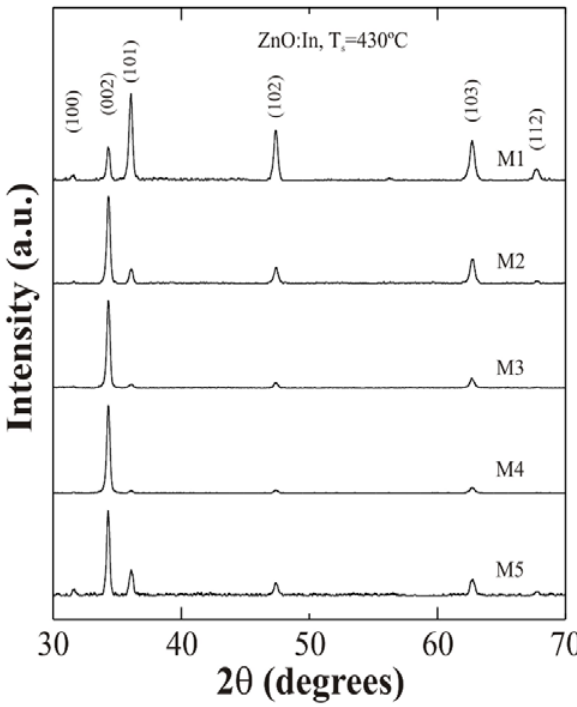
Figure 2. X-ray diffraction patterns of ZnO:In thin films deposited at 430 °C from the starting solutions with different water